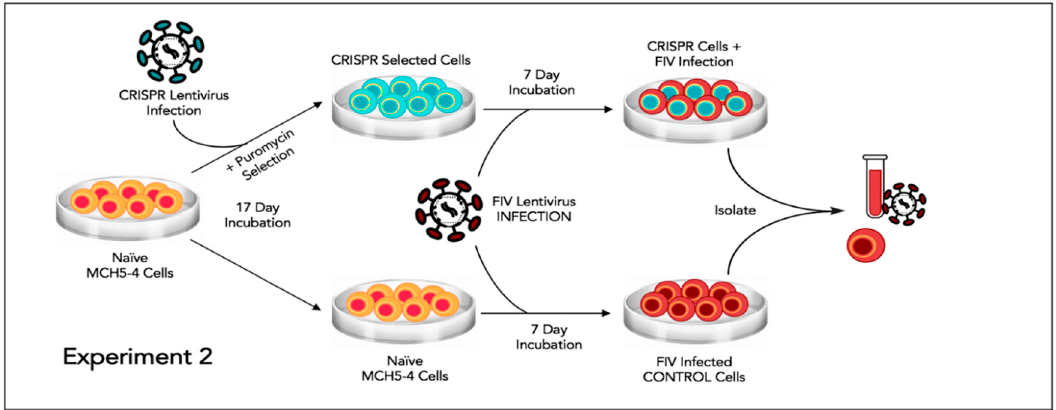
Figure 5. Schematic diagram of Experiment 2.